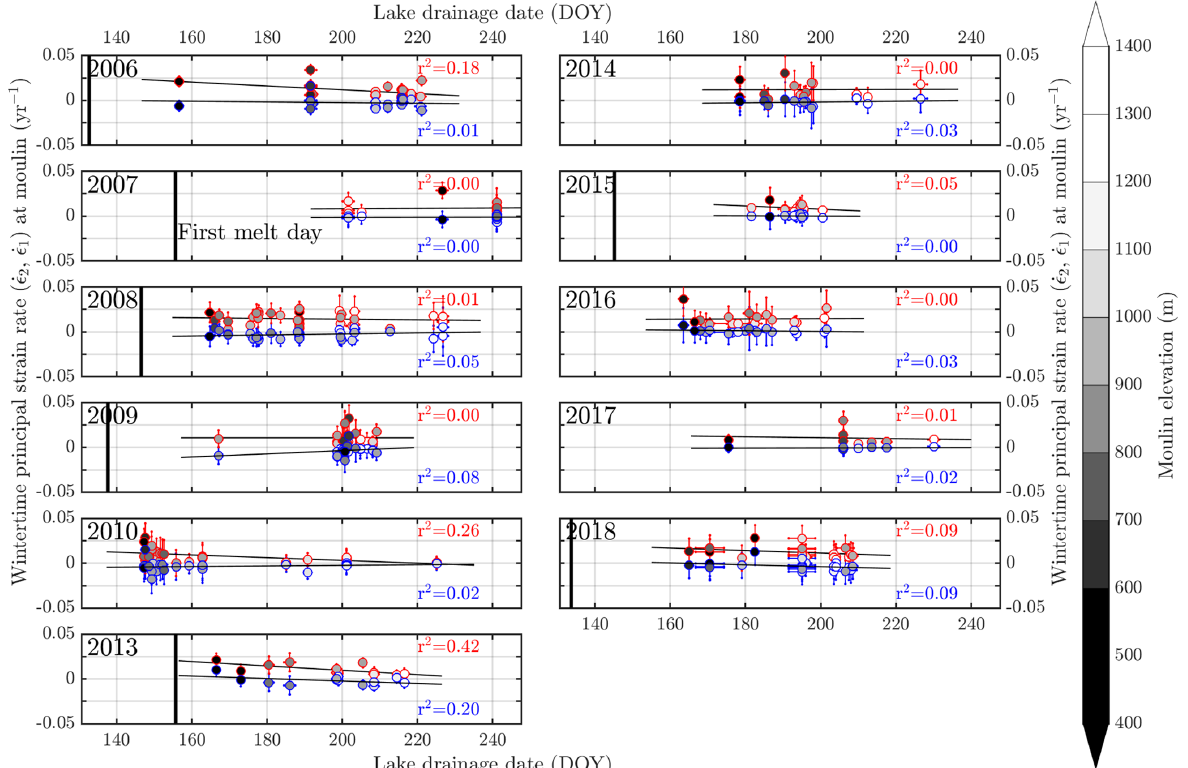
Figure 8. Wintertime strain rates at moulins associated with fast-draining lakes identified with high confidence, versus the dates of lake drainage. Strain rates are calculated from SAR-based velocity mosaics (Joughin et al., 2018b, 2010) for the winter immediately preceding the summer of lake drainage observations – i.e., the first panel shows strain rates at moulin sites observed in winter 2005–2006 versus the day of the year 2006 that the fast-draining lake associated with each moulin drained (see Fig. 1). Blue points show ˙ (cid:15) 1 , the more compressional principal strain rate; red points show ˙ (cid:15) 2 , the more extensional principal strain rate. Thin black lines show the least-squares fits to each time series with the Pearson correlation coefficients, r 2 , indicated. Bold black vertical lines show the day of each year that the 2m air temperature first exceeded 0 ◦ C at the Swiss Camp meteorological station (Steffen et al., 1996); in some years (e.g., 2010), this occurs earlier than the range of the graph. Elevations of each moulin (Bamber et al., 2013) are shown by the gray tone.